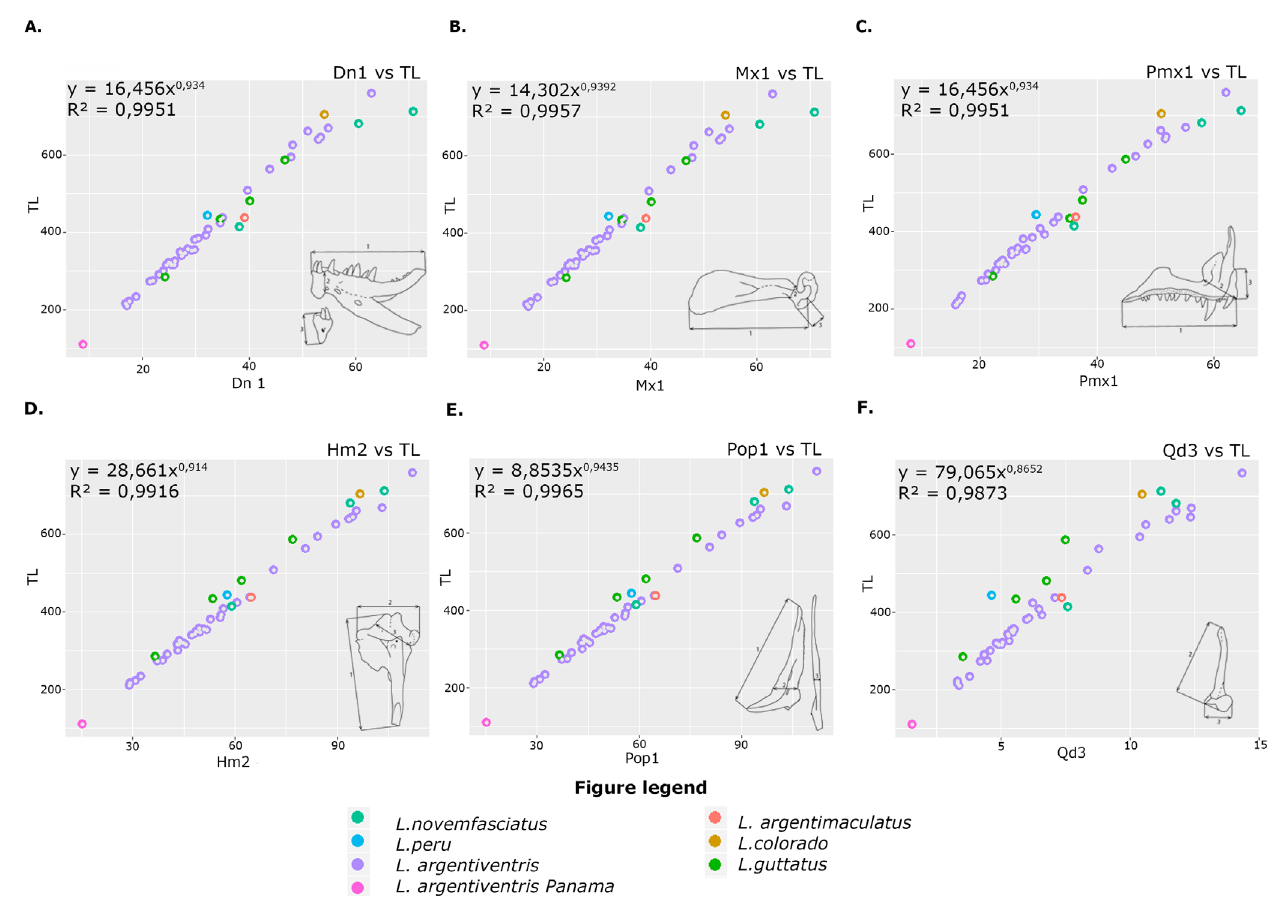
FIGURE 4 | Examples of Lutjanus argentiventris graphs modelling the regression formulae. A. Dentary (Dn1); B. Maxilla (M1); C. Premaxilla (Pmx1); D. Hyomandibula (Hm2); E. Preopercle (Pop1) and F. Quadrate (Qd3).